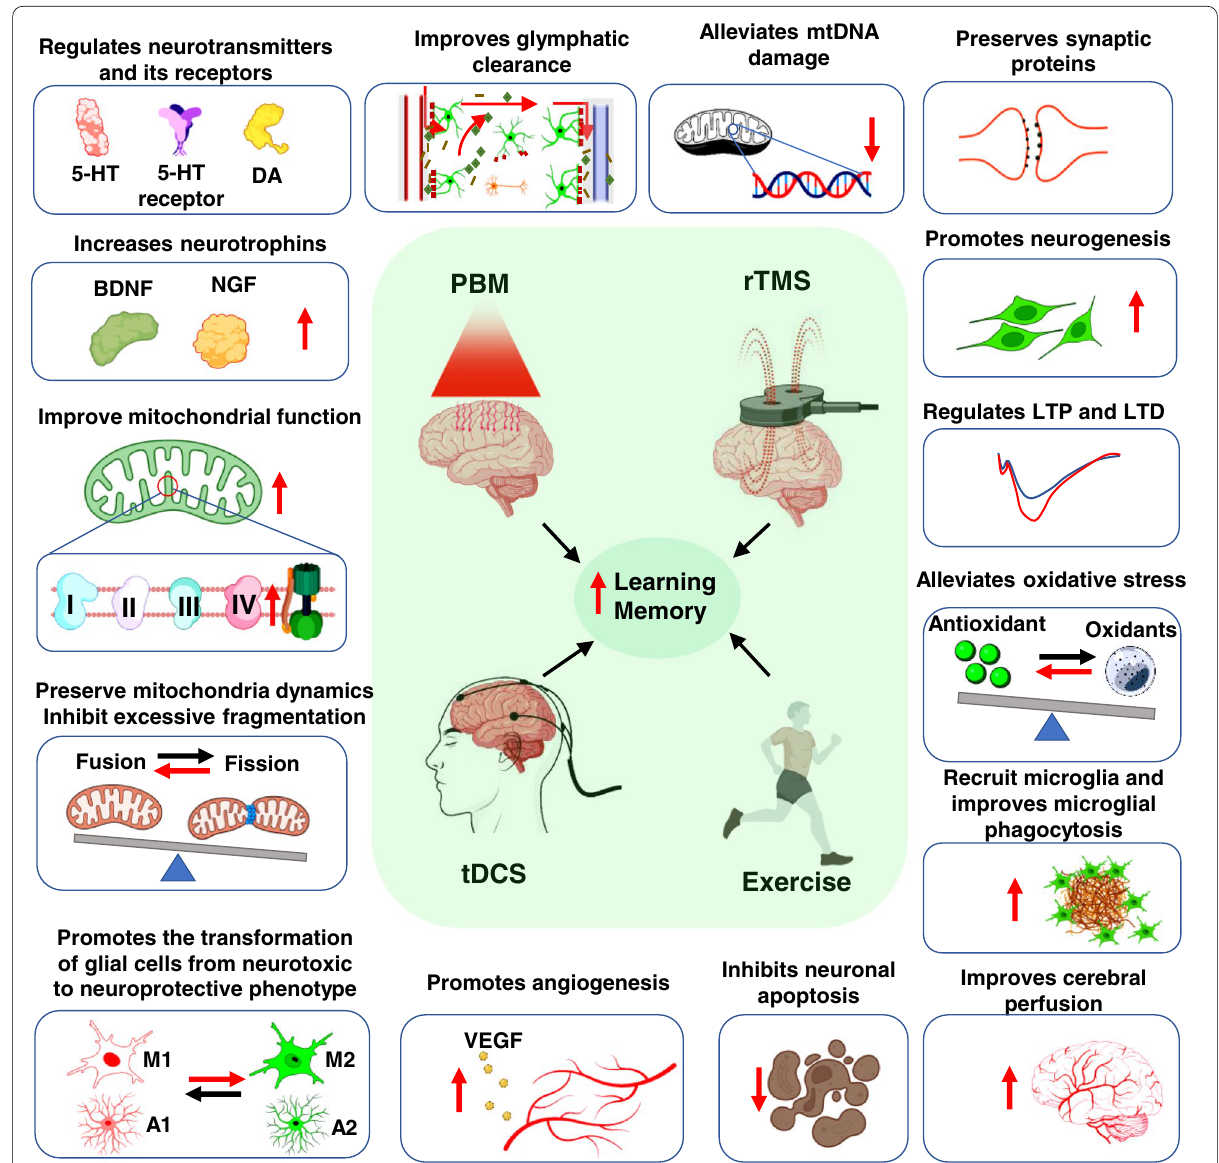
Fig. 7 Effects and mechanisms for non‑invasive therapies in AD. These non‑invasive treatments are able to alleviate neuronal apoptosis, improve cerebral perfusion, recruit microglia around amyloid plaques, improve microglial phagocytosis, attenuate oxidative stress, regulate LTP and LTD, promote neurogenesis, preserve synaptic proteins, alleviate mtDNA damage, improve glymphatic clearance, regulate neurotransmitters, increase neurotrophins, maintain mitochondrial function and mitochondrial dynamics, promote the transformation of glial cells from neurotoxic to neuroprotective phenotype, and promote